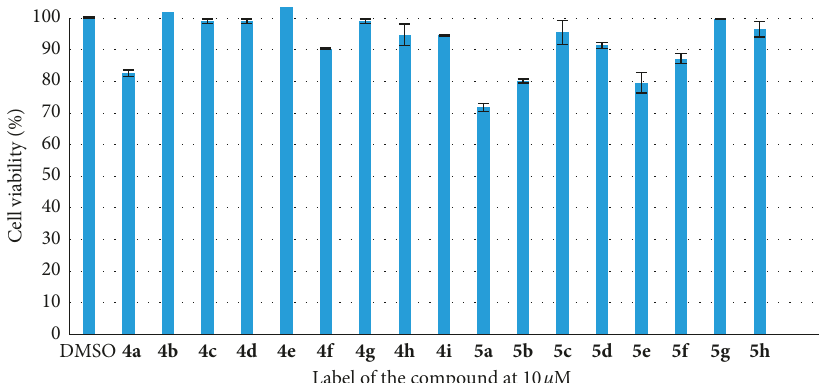
Figure 3: Cytotoxic activity for 4a-i and 5a-h against breast cancer cells